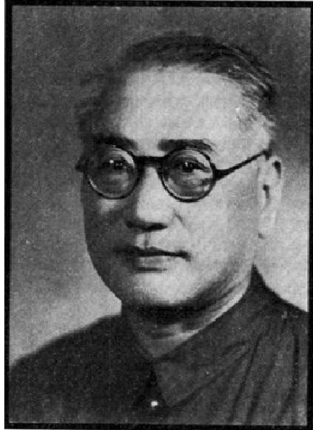
Figure 1. Shisan C. Chen (1894 – 1957).